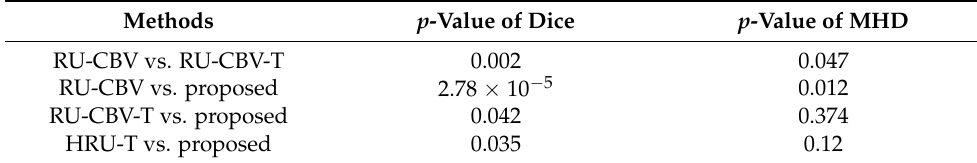
Table 5. Paired t -test with Bonferroni correction between the proposed and each ablated method. Methods p -Value of